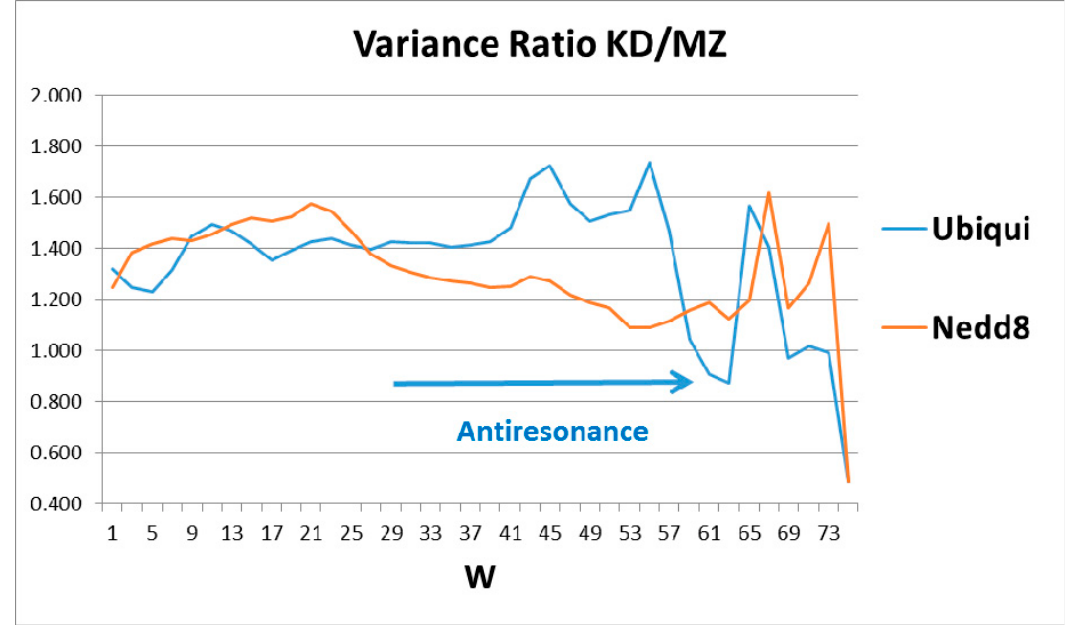
Figure 2. The human globular roughness, as a function of sliding window length, W , shows a rich structure for ubiquitin, but only weak structure for Nedd8. Here the structure above W 67 could be noise, but the two peaks centered on W = 45 and 55, and the sharp dip at 61–63, are genuine. Since ubiquitin is perfect, we expect that its second-order fine structure, monitored by the MZ variance, has become smooth (small variance), and that it is this MZ smoothness being small (or the KD roughness being large) that produces the two peaks in KD/MZ. Similarly, the 61–63 anti-resonance should be caused by a rough spot in MZ which evolution has not removed. This could be the two N- and C-wings of the overall profile (Figure 1) which are critical to its tagging opposing sides of target cracks.